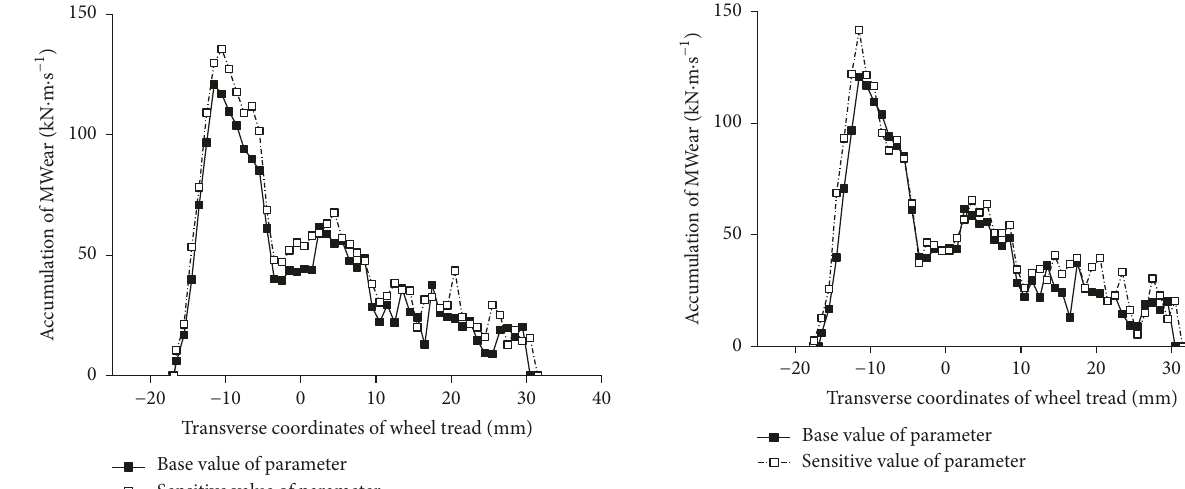
Figure 9: Influence of lateral stiffness of the air spring on the cumulative wear power dissipation of the